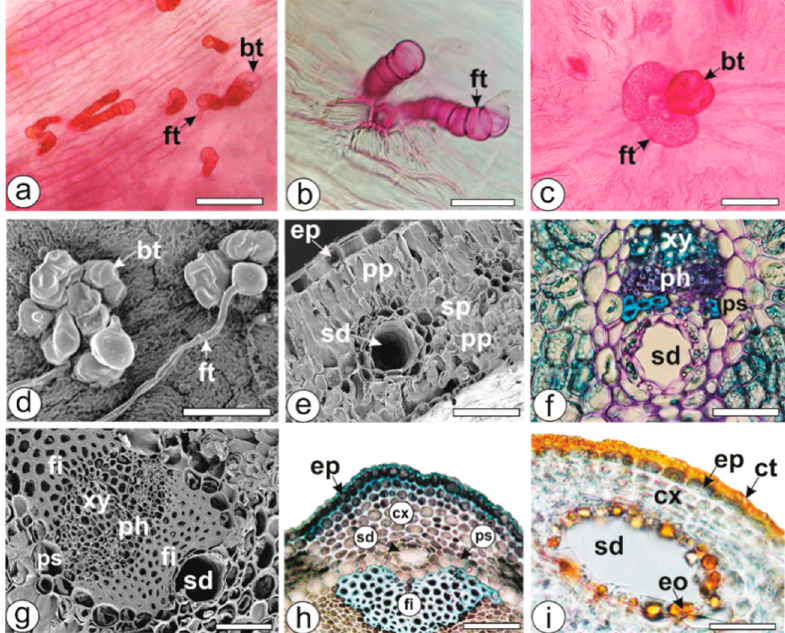
Figure 4. Anatomy of Baccharis [light ( a , b , c , f , h , i ) and scanning electron microscopy ( d , e , g )]. Leaf epidermis in surface view ( a – d ), cross-sections of the leaf ( e – g ) and of the stem ( h , i ). B. microdonta ( a ), B. pauciflosculosa ( b , e , f ), B. punctulata ( c , h ), B. reticularioides ( d , g ), B. sphenophylla ( i ). [bt–biseriate